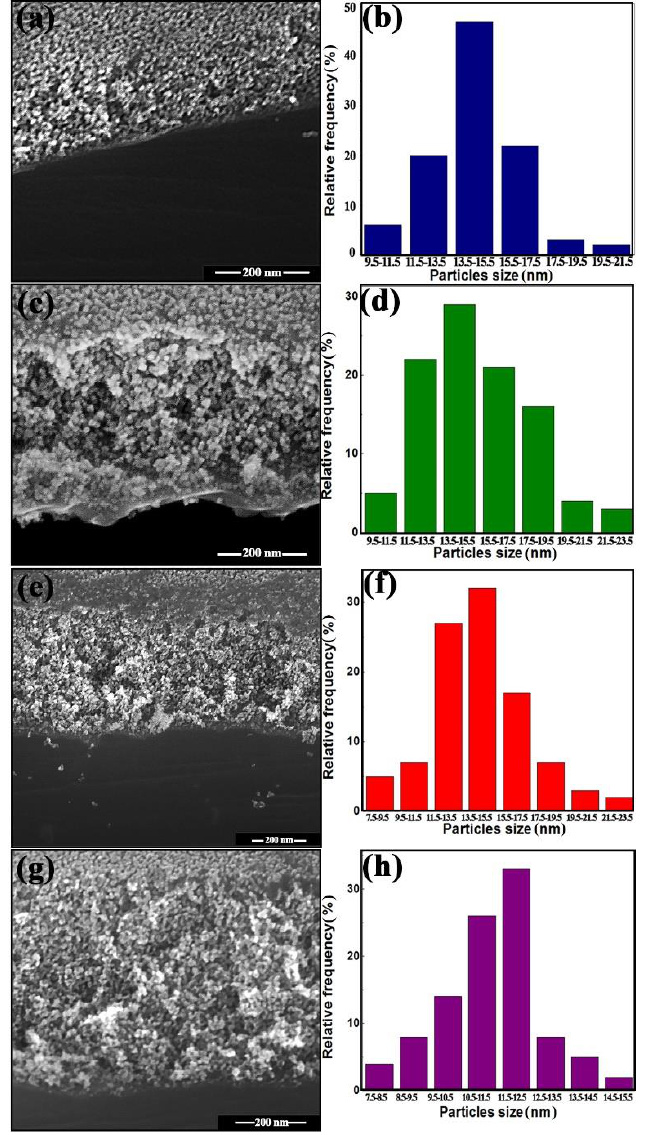
Figure 3. SEM microphotographs and particle size distribution of materials 0ZnO ( a , b ), 0.5ZnO ( c , d ), 1ZnO ( e , f ), 5ZnO ( g , h ).